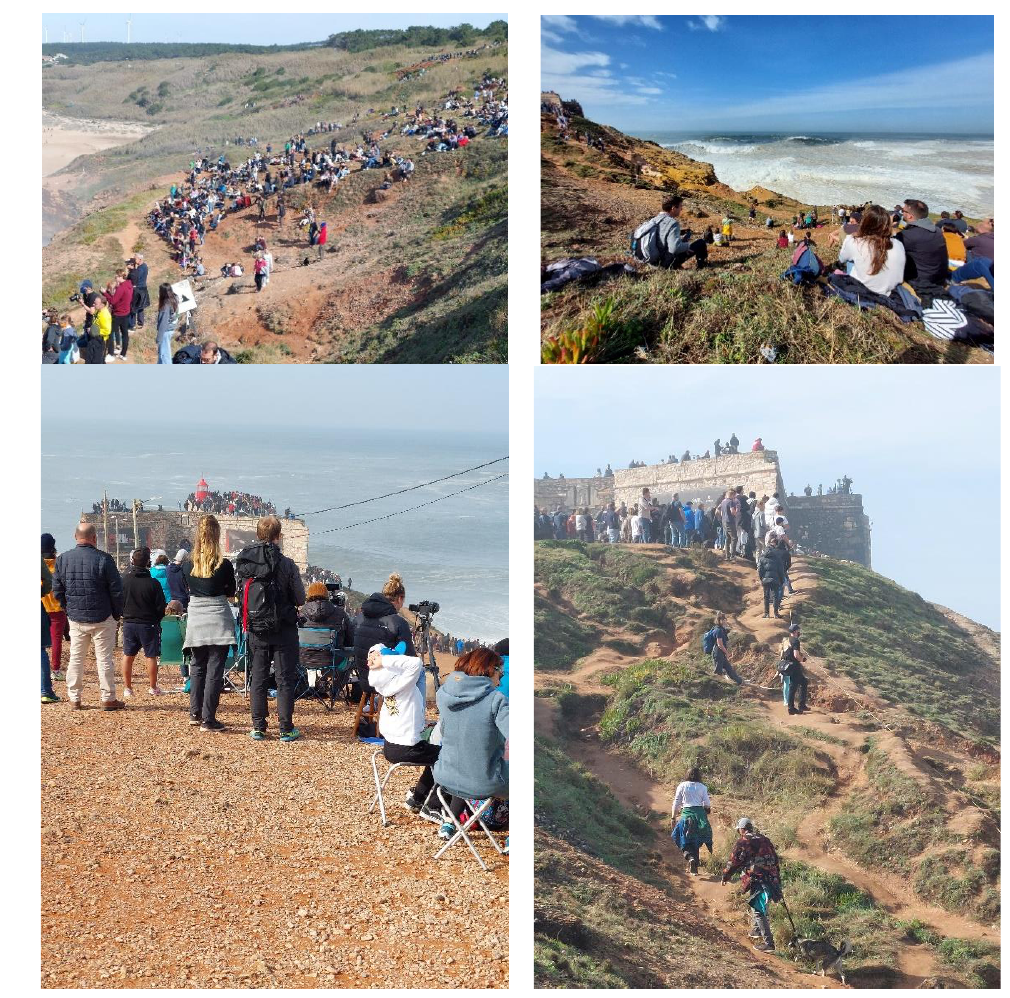
Figure 3. Authors’ photos taken on the ethnographic trip showing the spectators of giant waves. Table 3. Examples of the videos posted on YouTube less than 24 h after (accessed on 26 February 2022). Views 24 h after